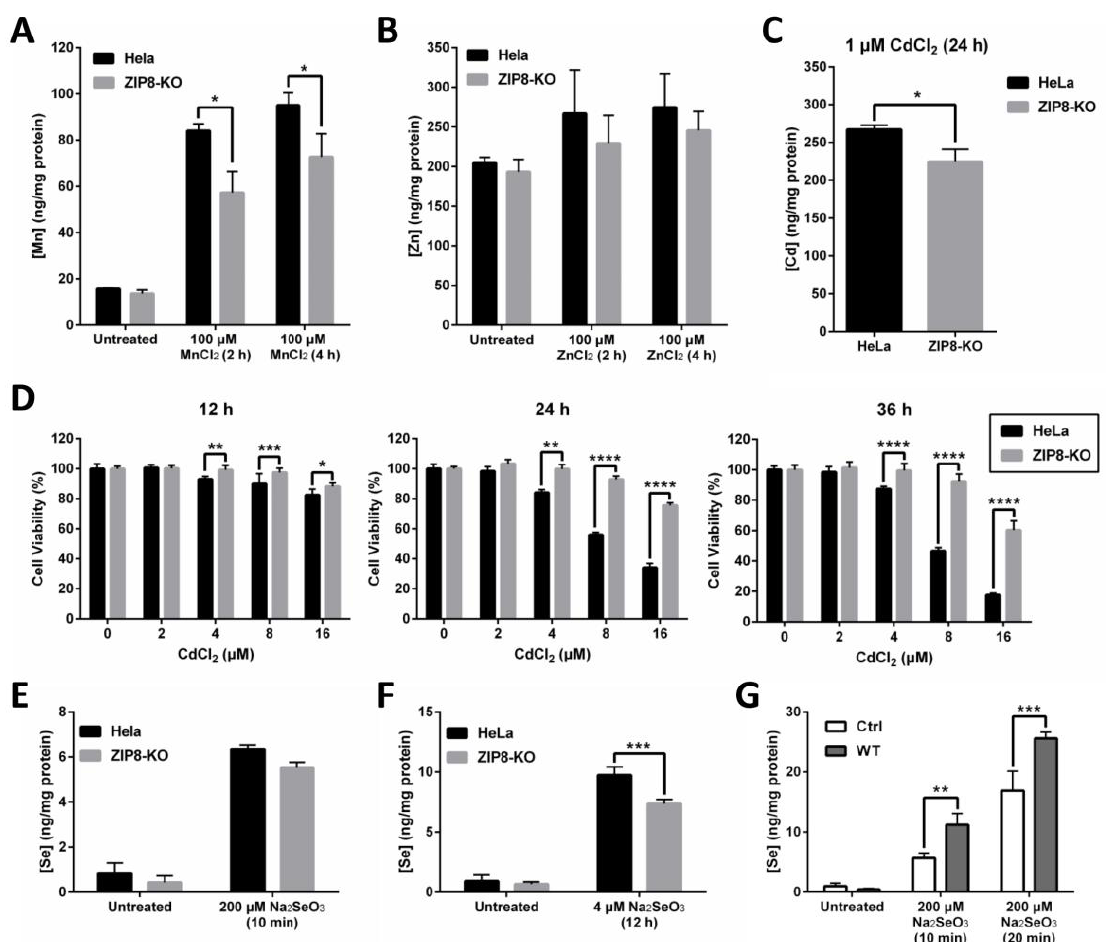
Figure 2. ZIP8-KO cells show decreased ability in intracellular Mn, Zn, Cd, and Se uptakes. ( A – C ) Intracellular uptake of Mn ( A ), Zn ( B ), or Cd ( C ) in HeLa parental and ZIP8-KO cells. After treating the cells with 100 µ M MnCl 2 or ZnCl 2 for 2 or 4 h or 1 µ M Cd for 24 h, the intracellular content of Mn, Zn, or Cd was assessed by ICP-MS. ( D ) The HeLa parental and ZIP8-KO cells were exposed to increasing amounts of CdCl 2 (0, 2, 4, 8, or 16 µ M) for 12, 24, and 36 h. NBB staining assay was performed to determine the cell viability. Data are representative of three experiments, and error bars represent standard deviation of six replicates. ( E , F ) HeLa parental and ZIP8-KO cells were treated with 200 µ M Na 2 SeO 3 for 10 min ( E ) or 4 µ M Na 2 SeO 3 for 12 h ( F ), followed by measurement of Se cellular contents using ICP-MS. ( G ) HeLa ZIP8-KO cells were transfected with pcDNA3.1 empty vector (as a control) or pcDNA3.1-ZIP8-WT. Cells were exposed to 200 μM N a 2 SeO 3 for 10 or 20 min, and then the intracellular Se concentration was measured by ICP-MS. Data are representative of two experiments, and error bars represent standard deviation of three replicates. p -value less than 0.05 was considered to be statistically significant. * p < 0.05, ** p < 0.01, *** p < 0.001, **** p < 0.0001.